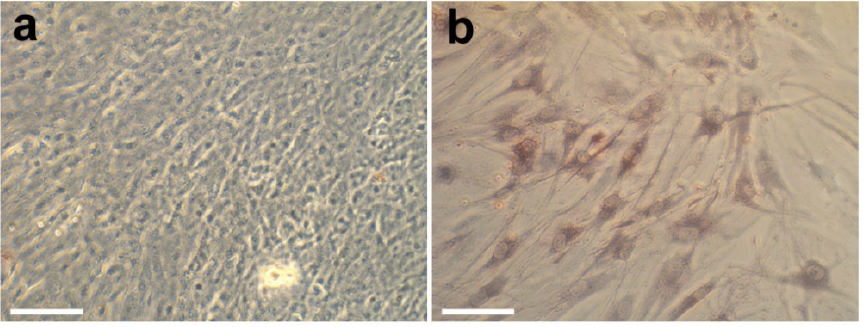
Figure 12. Optical microphotographs of MG-63 ( a ) and FetMSCs cells ( b ) on the surface of control samples (glass slides) after cultivation for 2 weeks. Scale bars—50 µm.